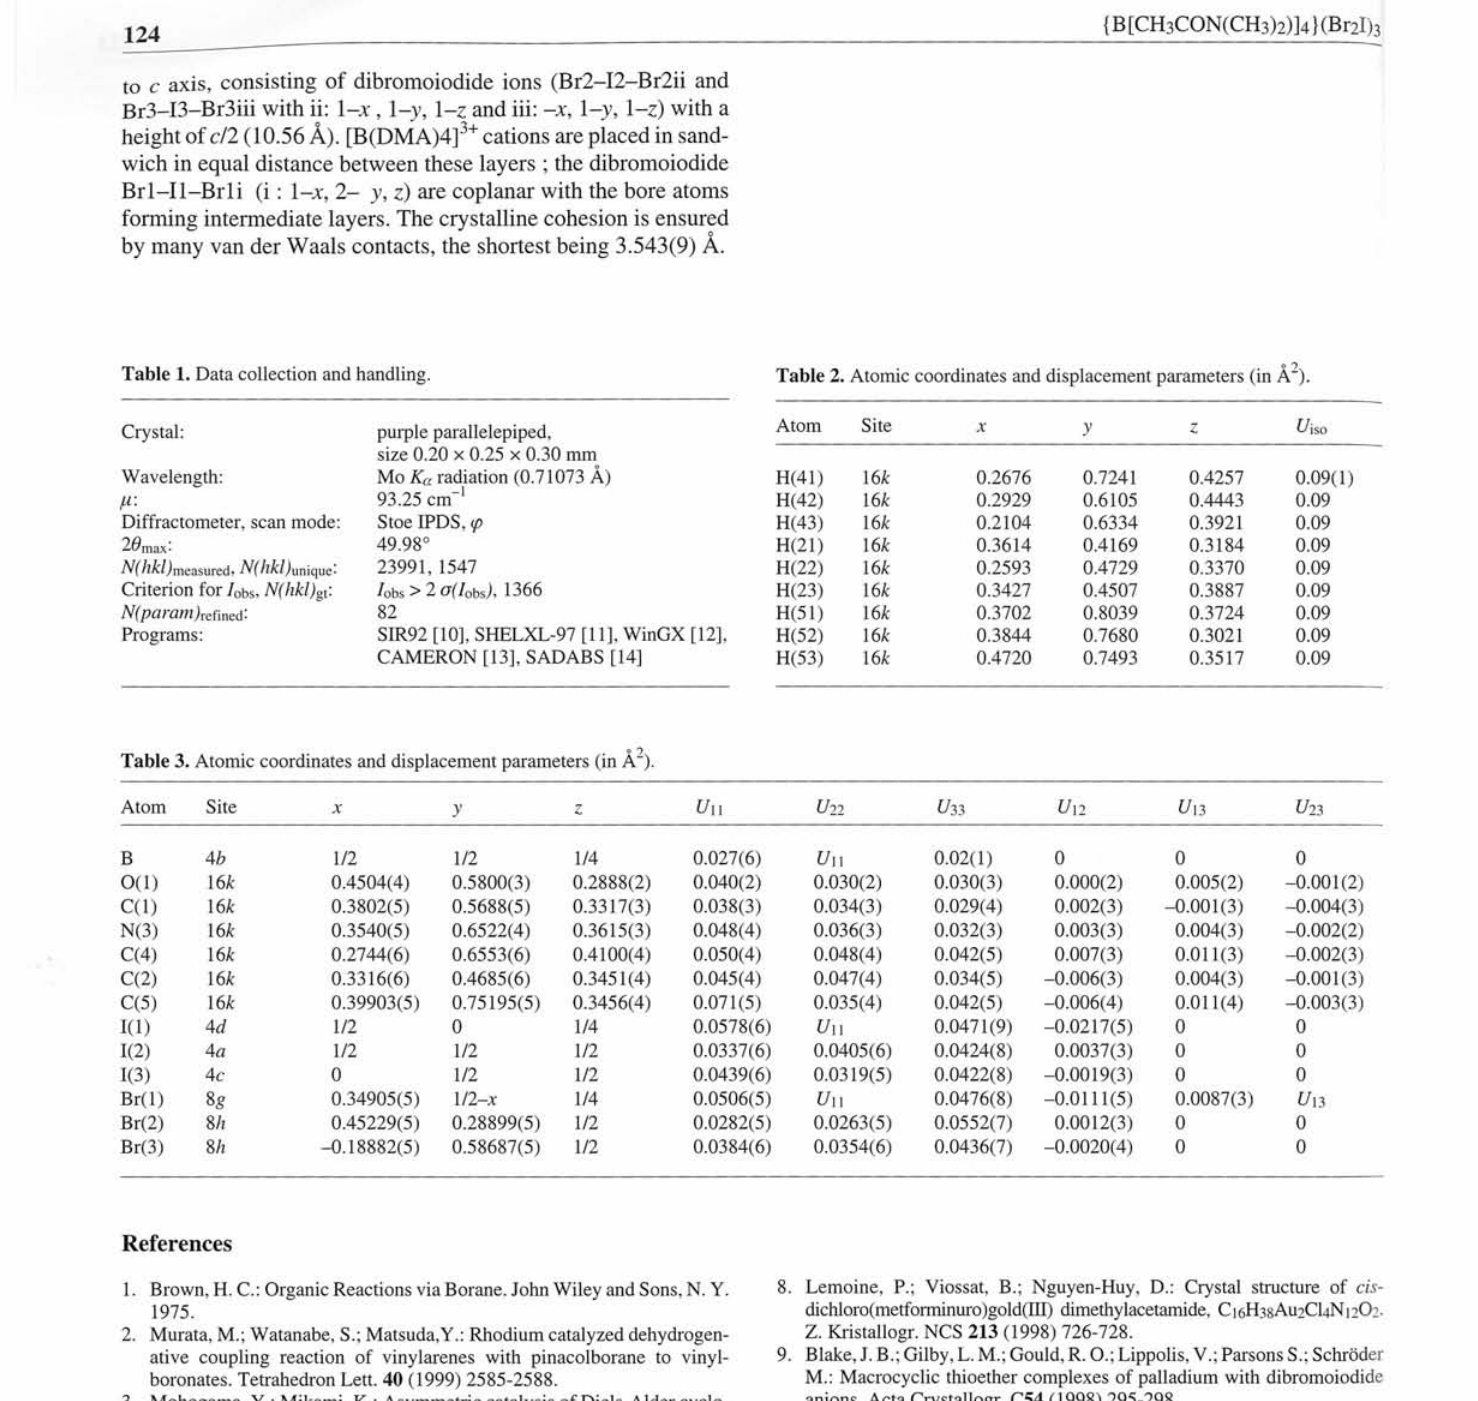
Table 1. Data collection and handling. Table 2. Atomic coordinates and displacement parameters (in Â 2 ).